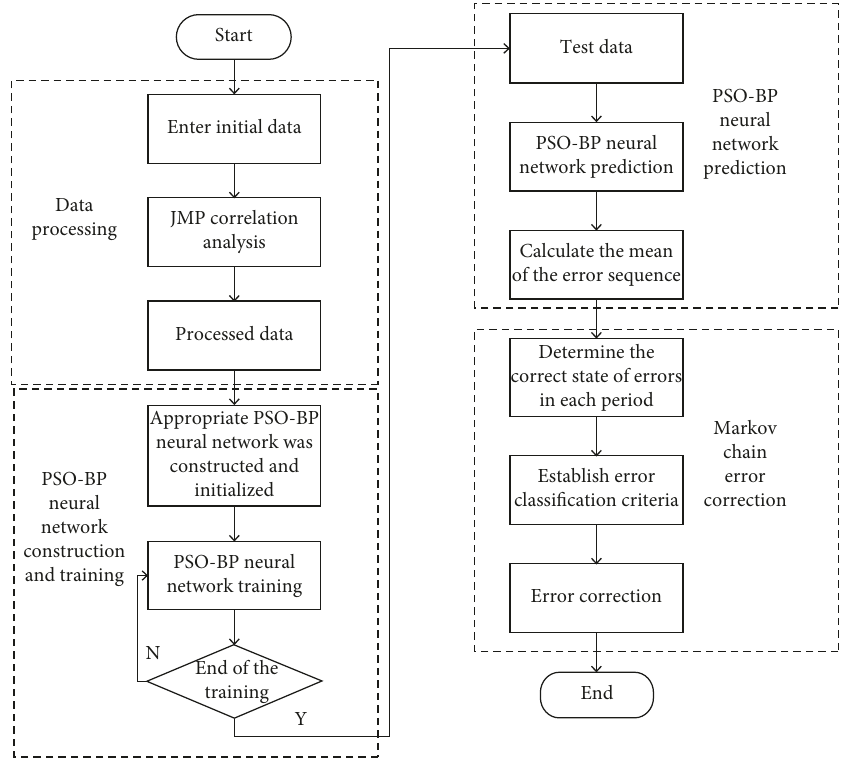
Figure 1: Flow of dynamic prediction method for cooling load. Table 1: Correlation between input parameters and cooling load at time T